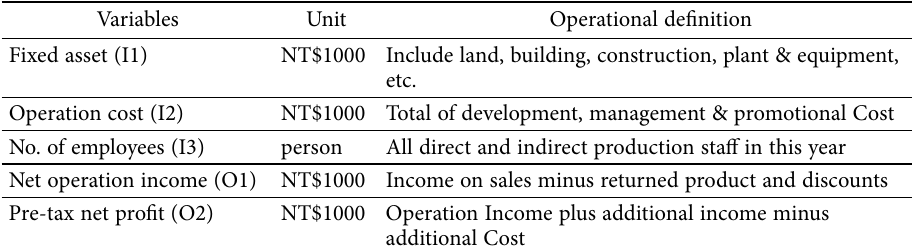
Table 2. Input and output variables